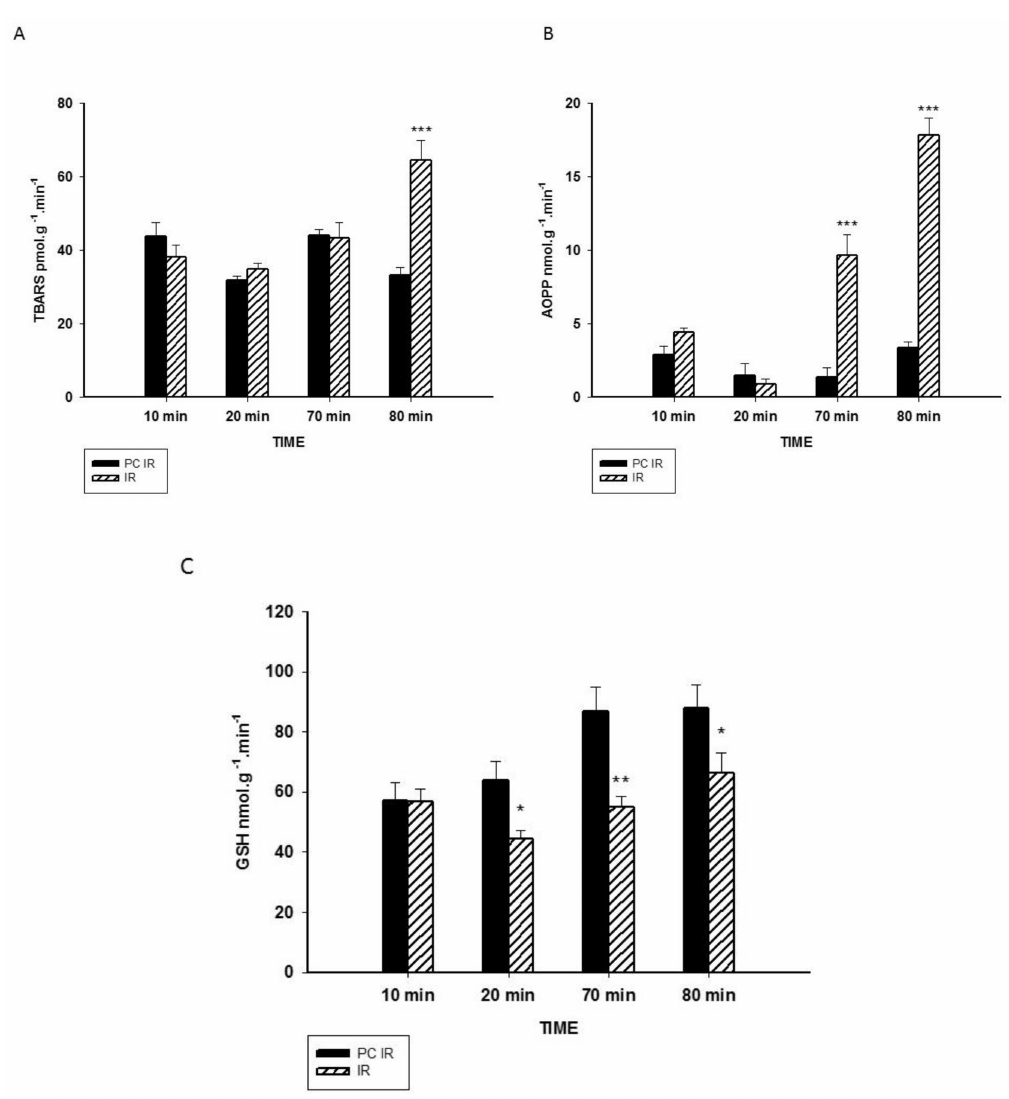
Figure 4. Effect of hypothermic perfusion on biomarkers of oxidative stress in the perfusate. ( A ) Lipid peroxidation (TBARS) ( B ) Advanced oxidation protein products (AOPP) and ( C ) GSH levels in the perfusate. Data is mean ± SEM of six animals. Significantly different from corresponding PC IR values by Student’s t test: * p < 0.05, ** p < 0.01 and *** p <